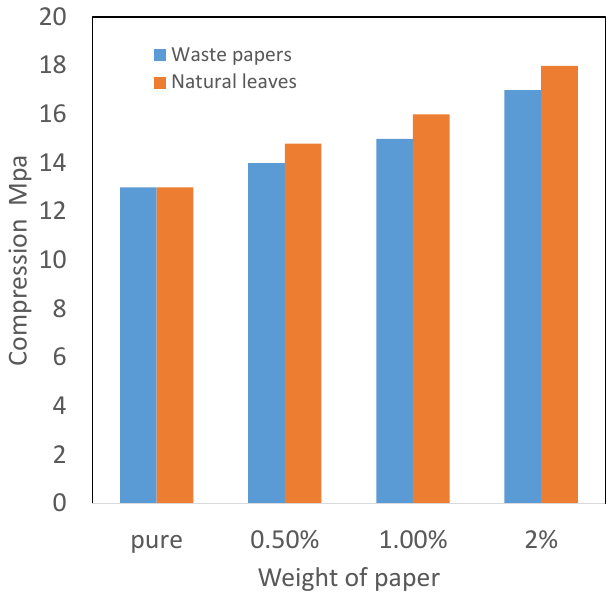
Fig. 12: Compression test of the reinforced mortars.